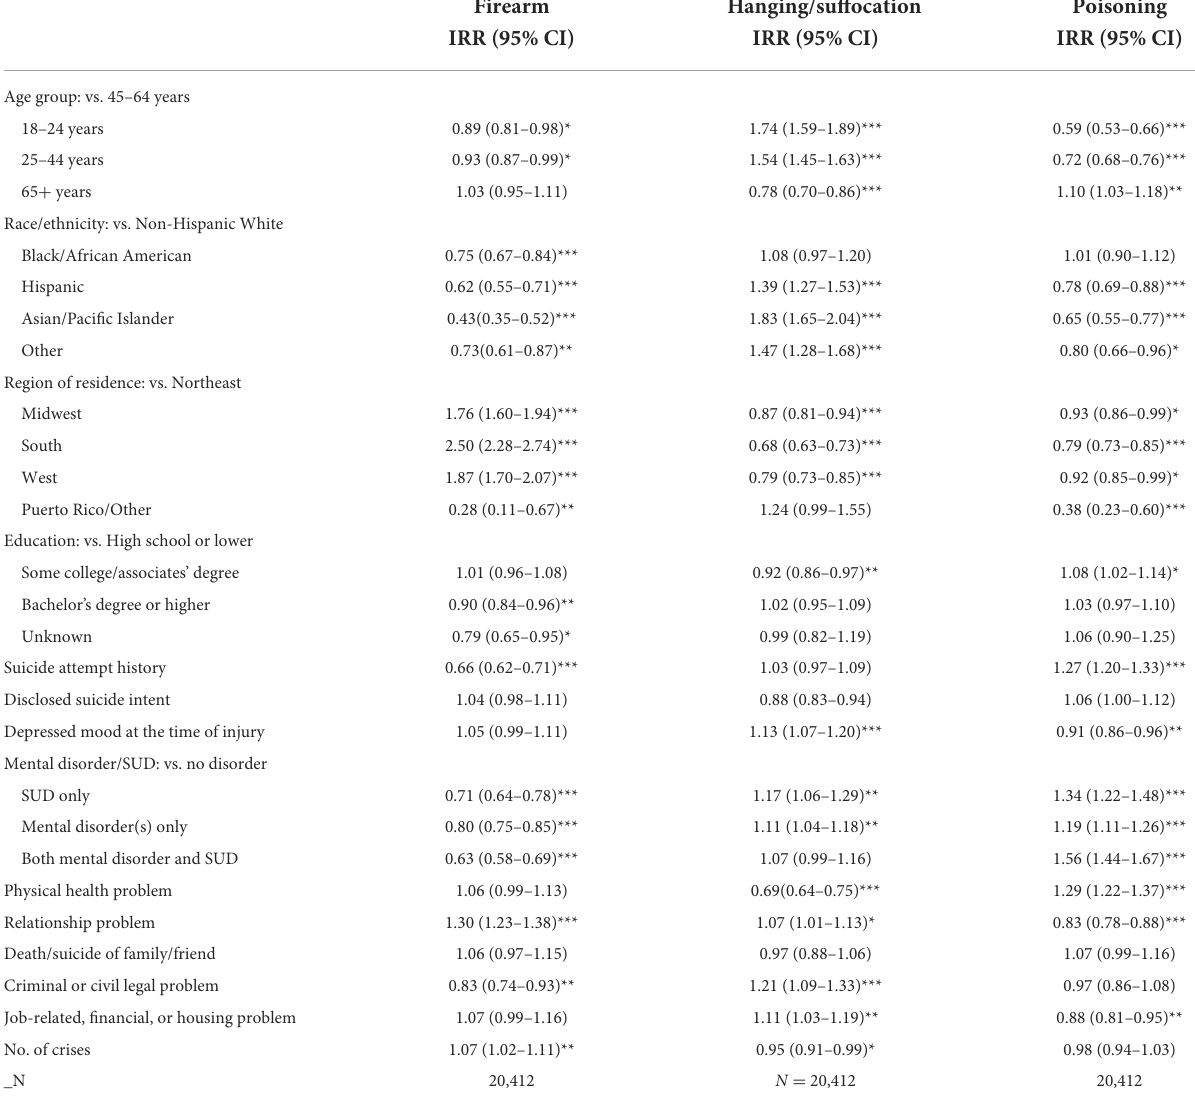
TABLE 5 Correlates of firearm, hanging/suffocation, and poisoning use among women: Results from generalized linear modeling for a Poisson distribution with a log link. Firearm